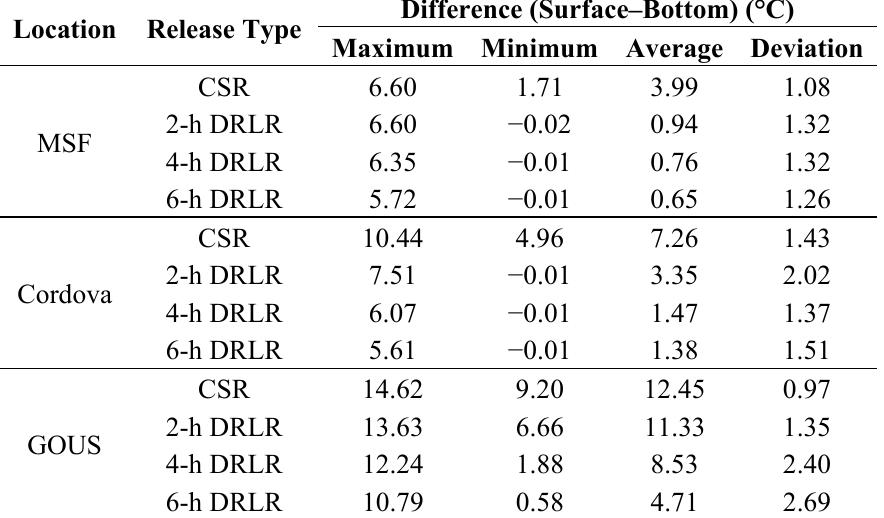
Table 3. Statistical summary of simulated differences (°C) between surface and bottom temperatures at MSF, Cordova, and GOUS for CSR only, 2-h, 4-h and 6-h